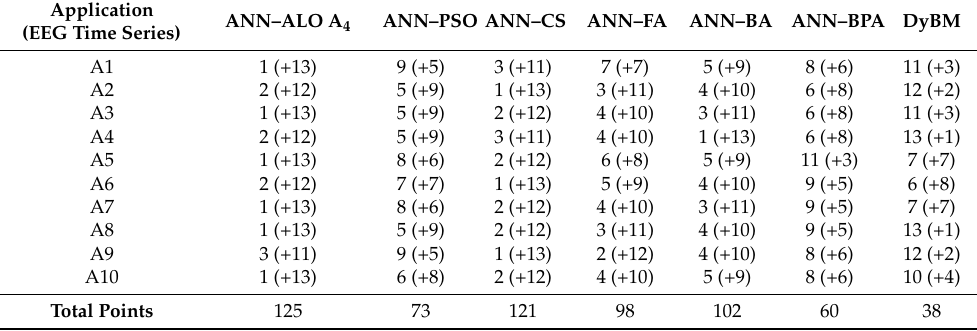
Table 14. The ranks and obtained points from each approach for the predictions of the EEG time series (set